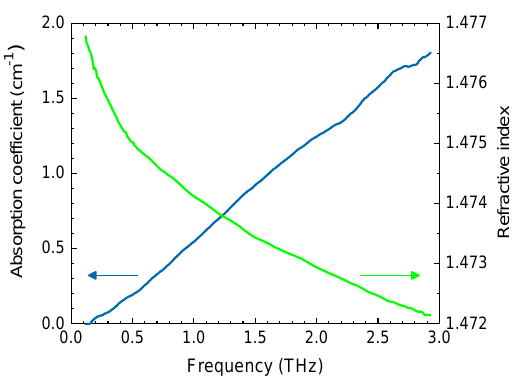
Figure 2. Absorption coefficient and refractive index of paraffin oil.